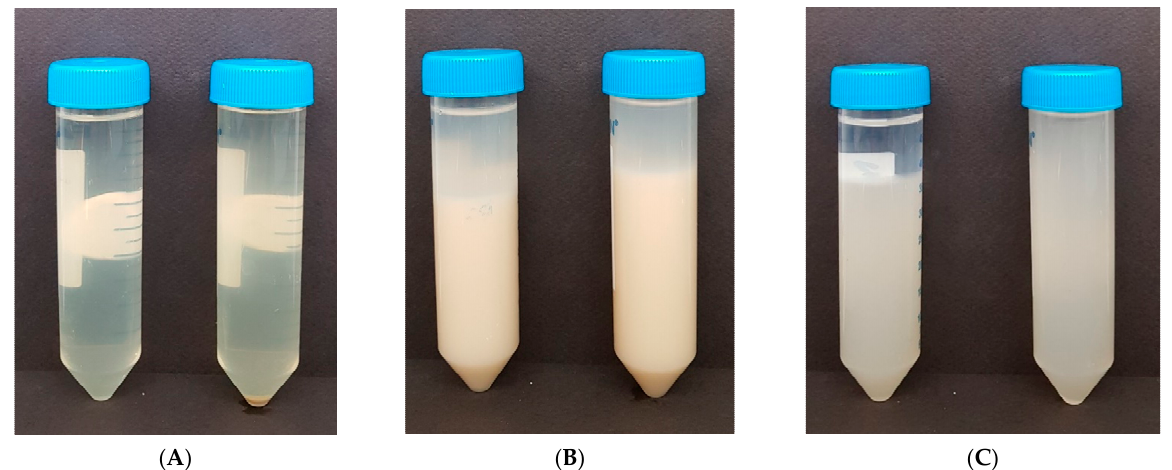
Figure 6. Syneresis of plant fiber solutions before and after the physical treatment (homogenization and pasteurization): ( A ) AF (acacia fiber, ( B ) SF (soy fiber), ( C ) CF (citrus fiber) (left: before physical treatment, right: after physical treatment).